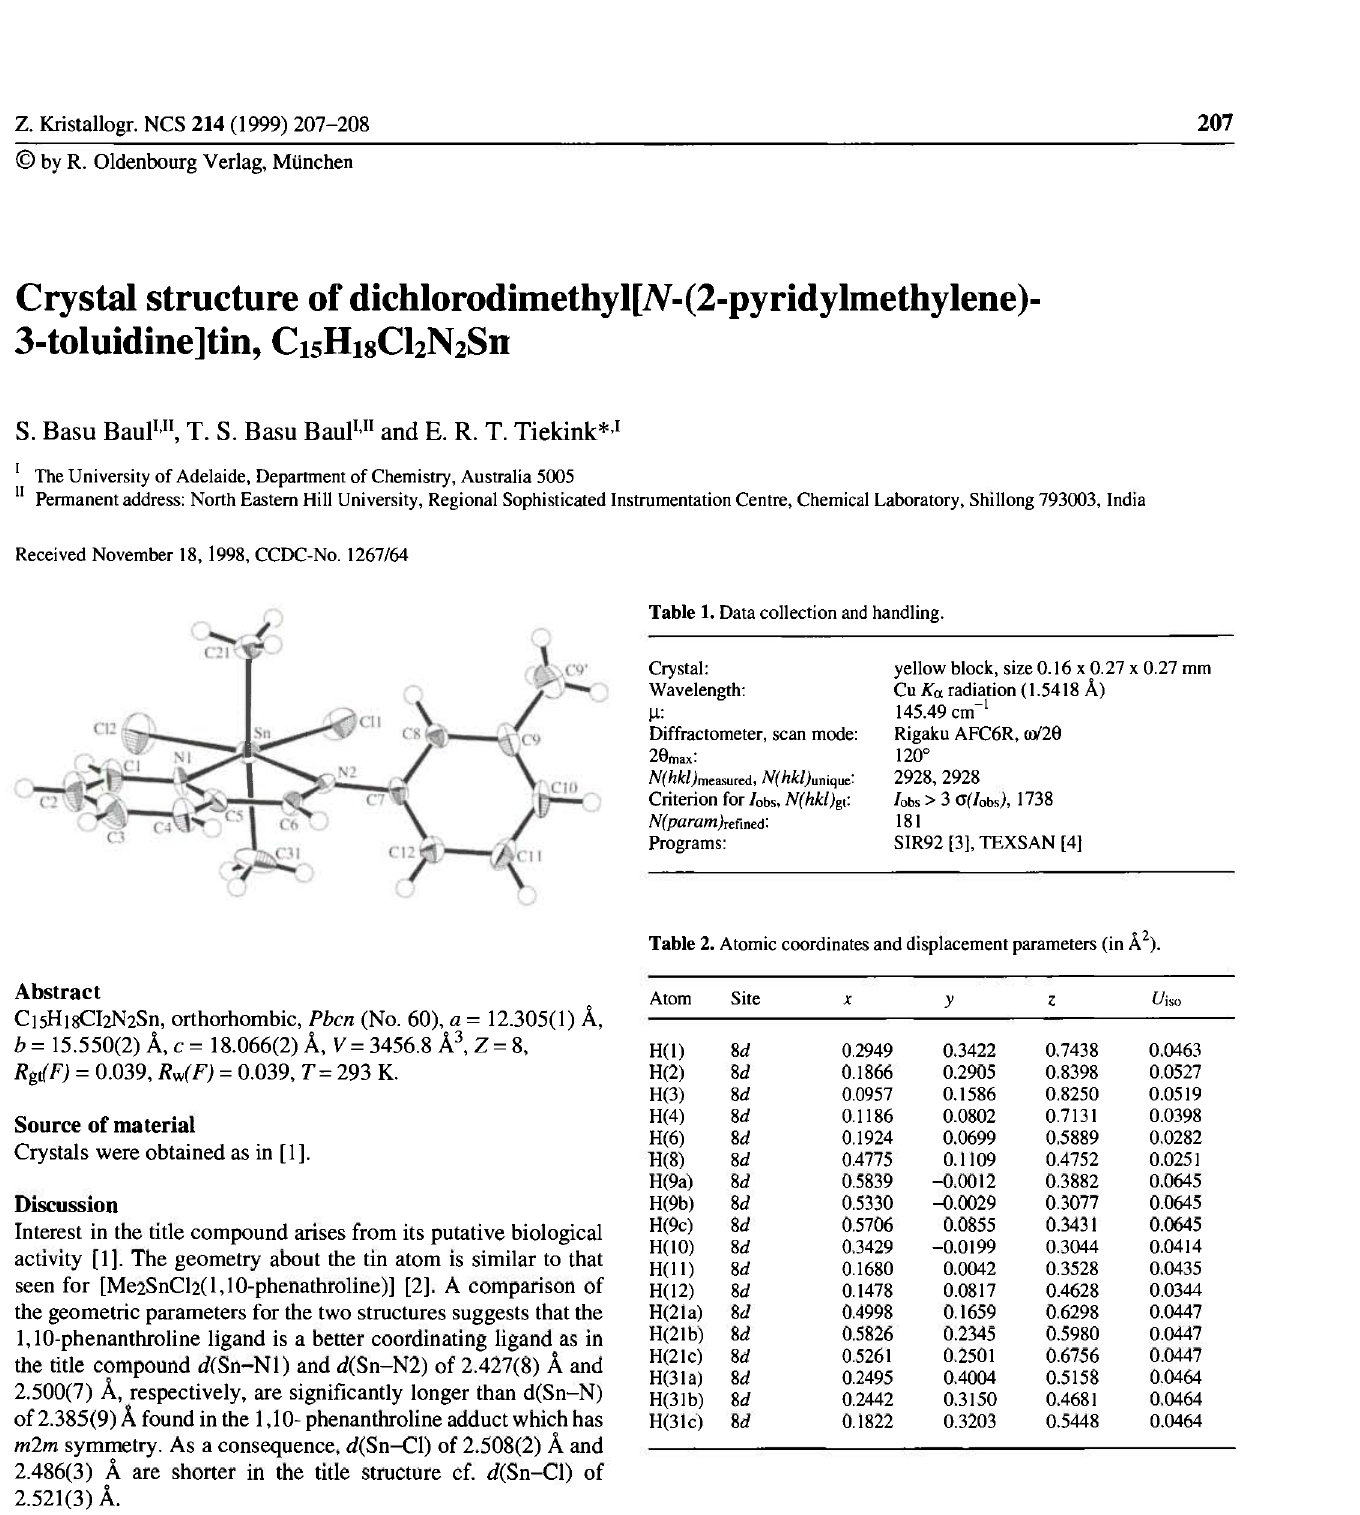
Table 3. Atomic coordinates and displacement parameters (in Ä 2